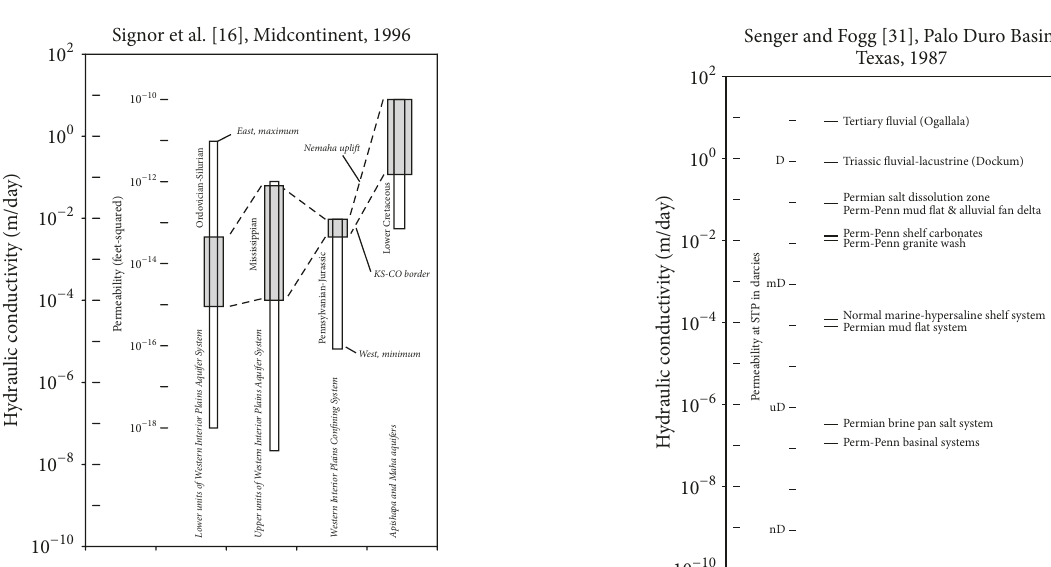
Figure 19: Permeability values selected by Senger and Fogg [31] for hydrologic units in a study of the Palo Duro Basin, Texas. Values range over seven orders of magnitude, from one darcy (D) to 0.1 microdarcies(uD).Theleftaxislabelshowsequivalentsforhydraulic conductivity in m d −1 using a conversion factor of 1D = 0.835 md −1 . STP, standard temperature and pressure; Perm-Penn, Permian- Pennsylvanian. The ratio of vertical to horizontal permeability 𝑘 ranges from 0.01 to 1.0.